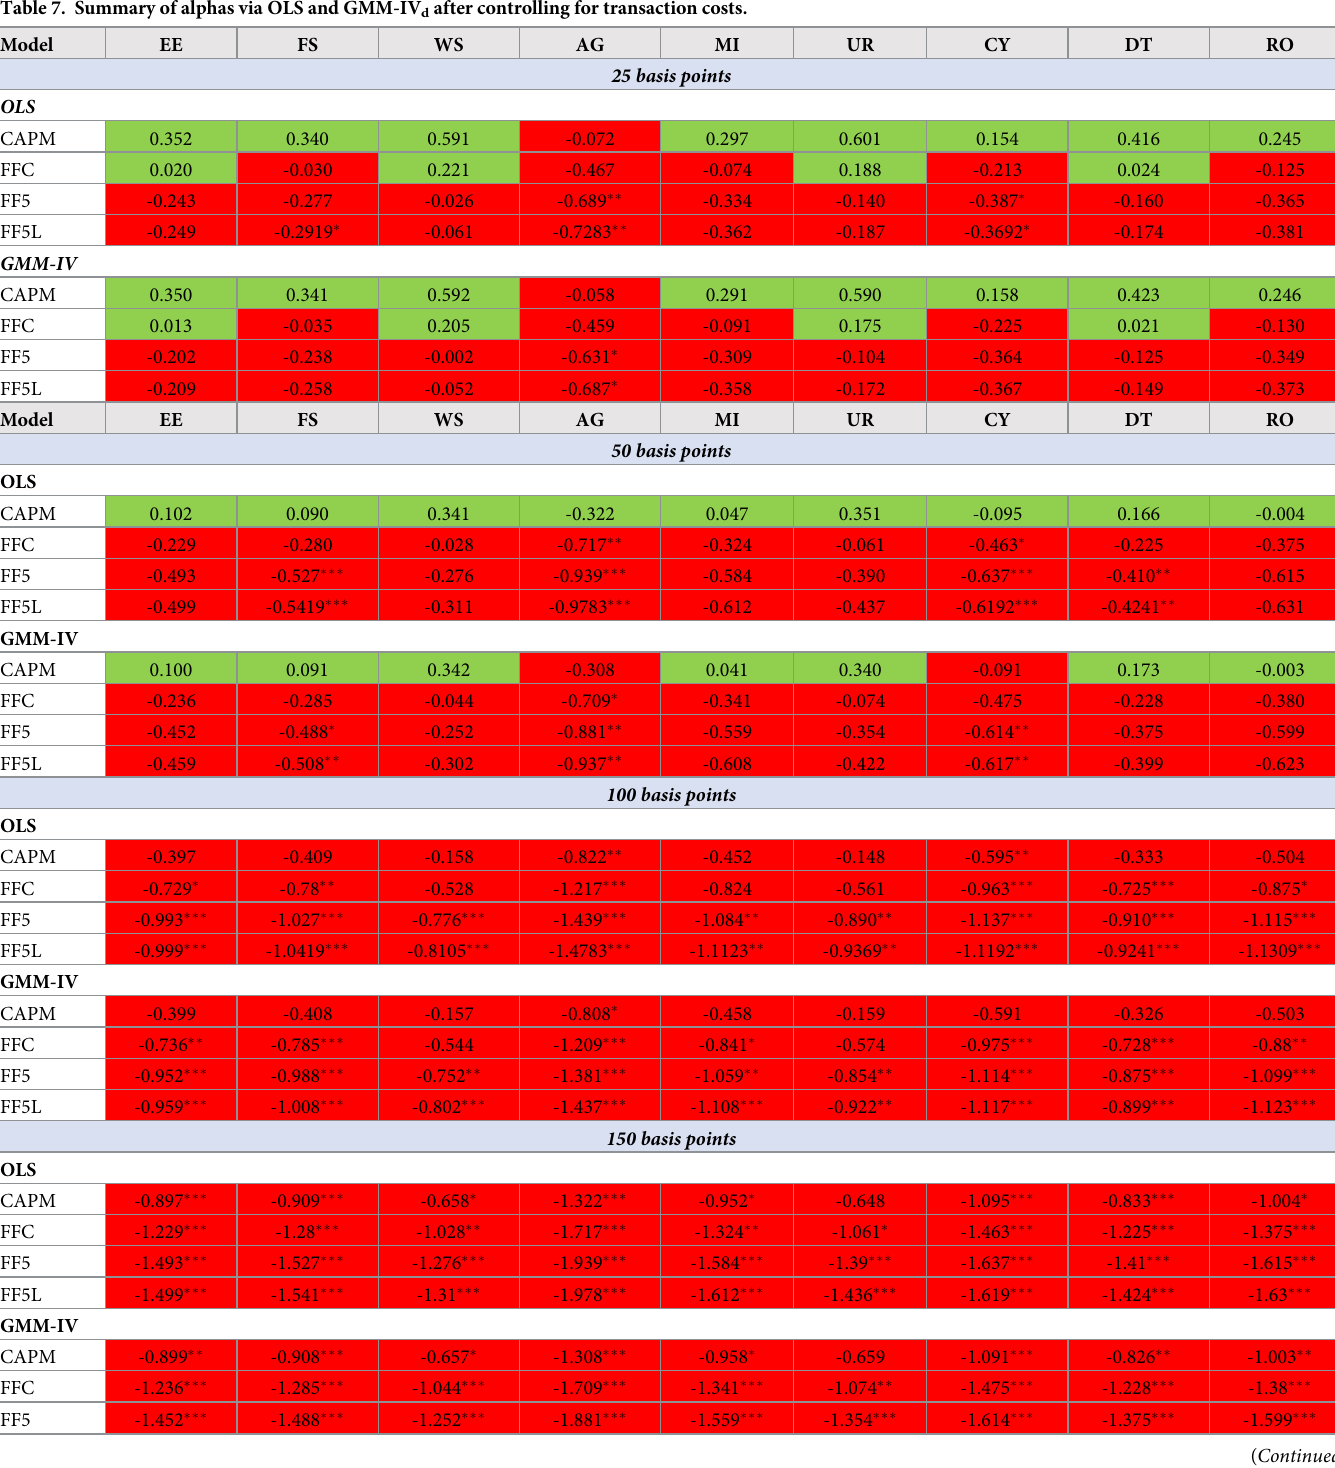
Table 7. Summary of alphas via OLS and GMM-IV d after controlling for transaction